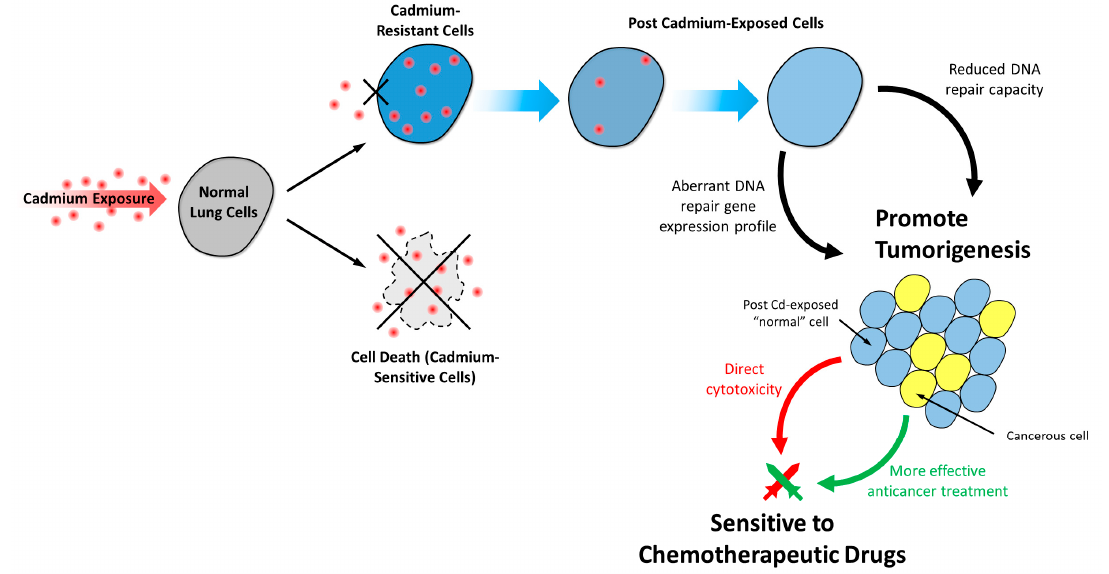
Figure 7. The potential long-term cytotoxic and carcinogenic effects of post-chronic Cd exposure on human lung cells. Post Cd-exposed cells have an aberrant DNA repair gene expression profile and reduced DNA repair capacity which can contribute to carcinogenesis. These post Cd-exposed cells are more sensitive to chemotherapeutic drugs, which may represent a double-edged sword: on the one hand, post Cd-exposed cells are more sensitive to chemotherapy which is beneficial in terms of anticancer treatment; on the other hand, exposure to Cd may also make the patients that have to undergo chemotherapy more vulnerable to drug